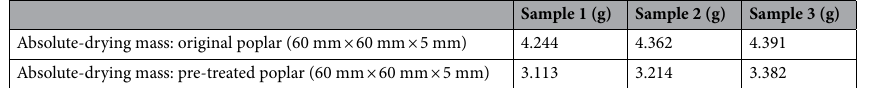
Table 1. The absolute-drying masses: original, and pre-treated poplar specimens.